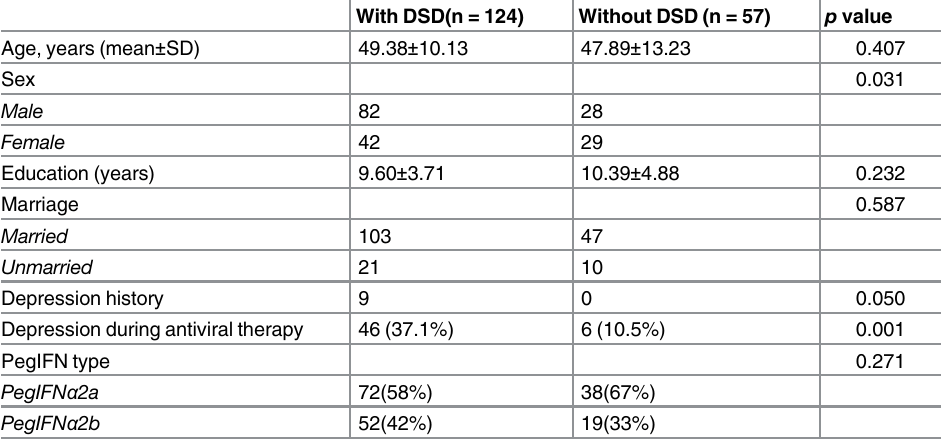
Table 2. Comparison of patients with or without DSD during PegIFN+RBV treatment.